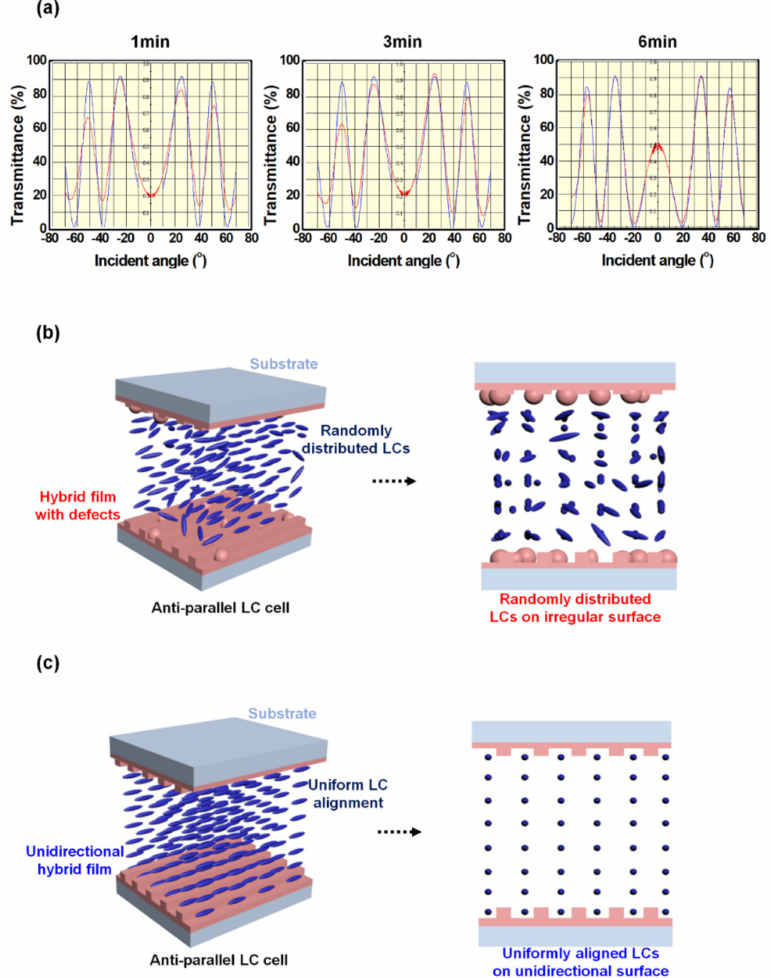
Figure 7. ( a ) Oscillated transmittance graphs as functions of the incidence angle (from –70 ◦ to 70 ◦ ) of the AP–LC cells produced from 1 min, 3 min, and 6 min UV–exposed hybrid films. ( b ) Irregular (with defects) and ( c ) uniform unidirectional surface hybrid–film-based AP–LC cells with their LC alignment state and corresponding front